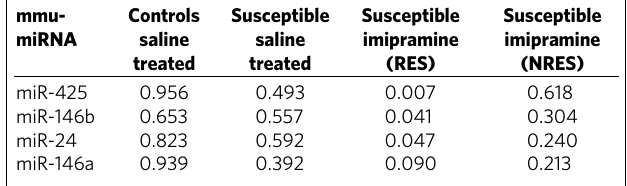
Table 3 | Animal model of MDD. Table 4 | MiRNA expression in vPFC of post-mortem brains of subjects with MDD and